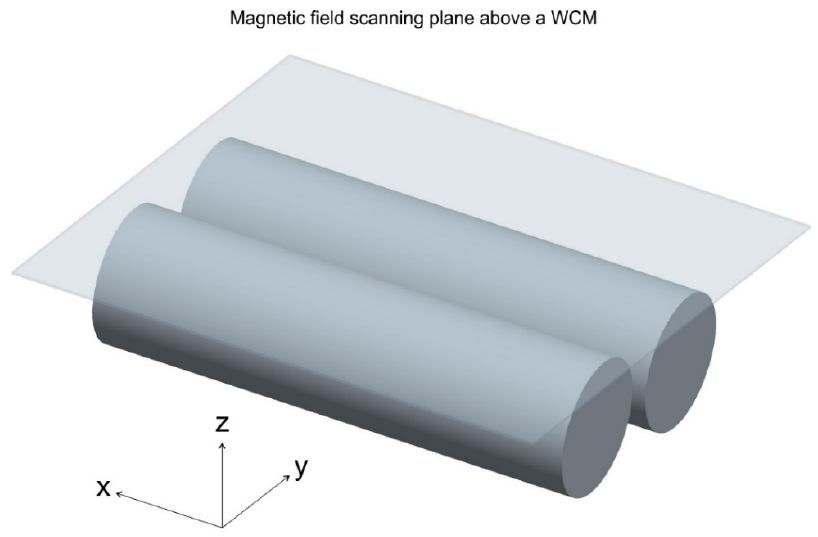
Figure 3 . Sketch showing the area (20 × 20 cm 2 ) scanned for the magnetic field measurements with the water core magnet underneath (two cylinders, 18 cm length, 5 cm diameter, 1 cm apart).